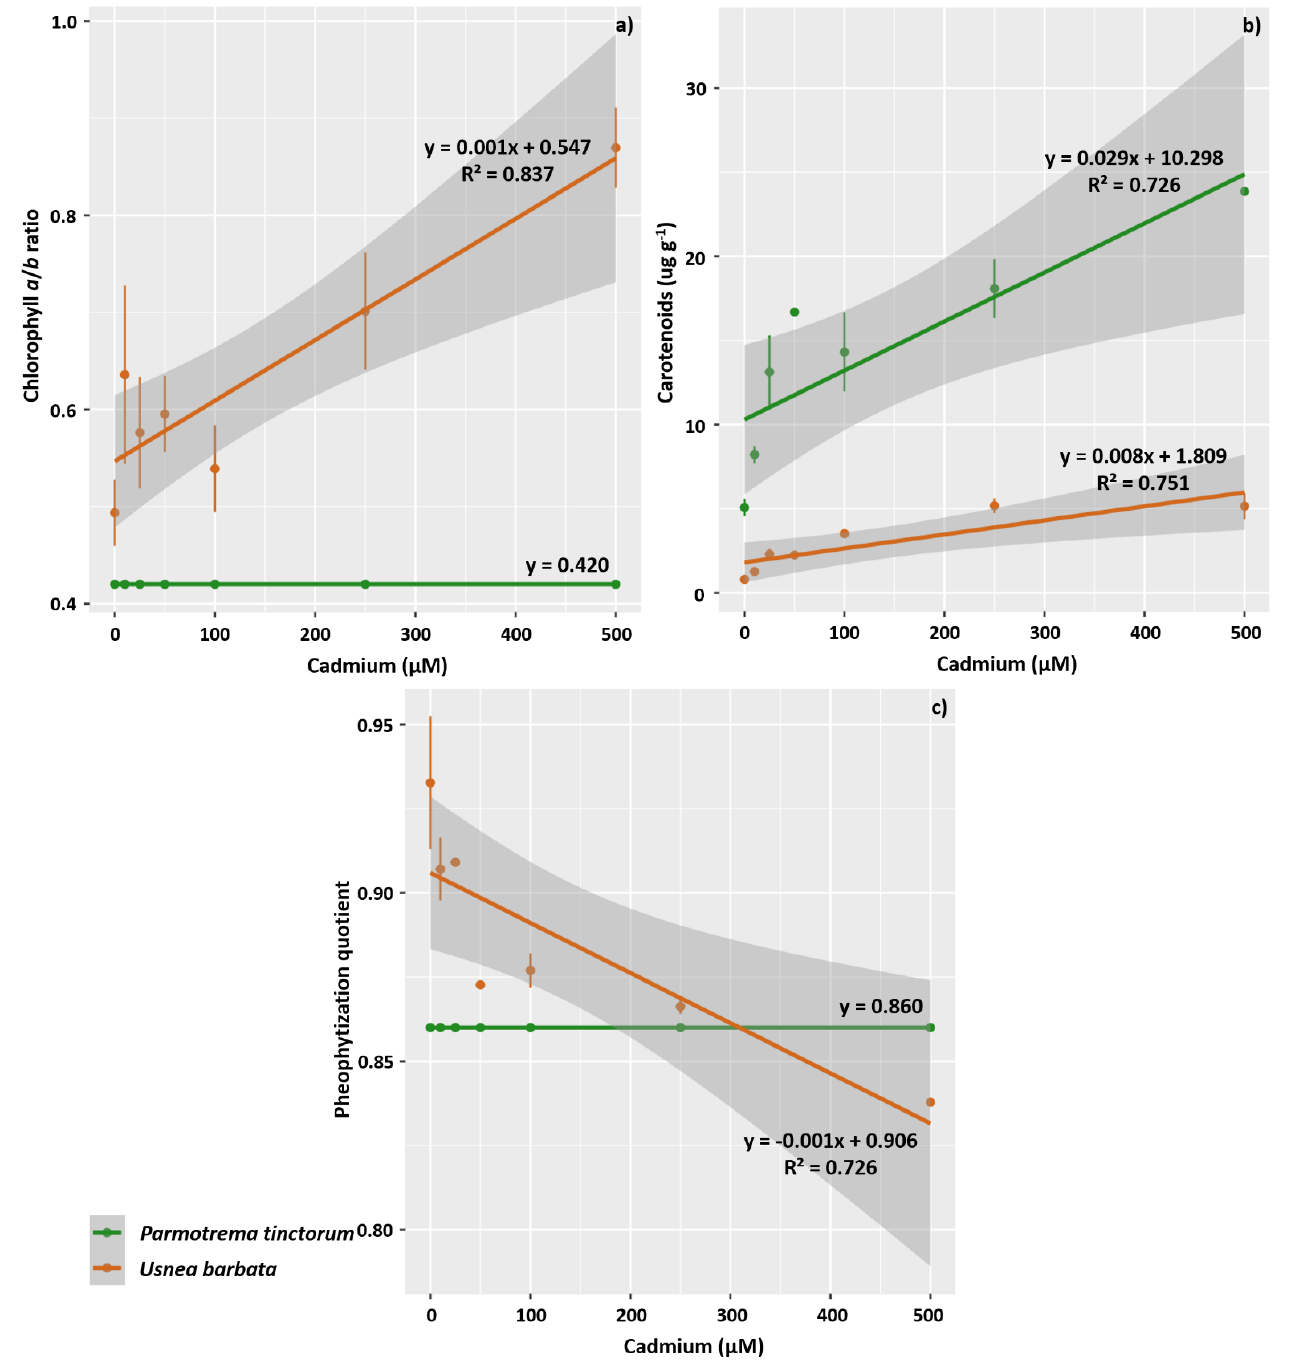
Figure 5. Chlorophyll a / b ratio ( a ), carotenoid concentration ( b ), and pheophytization quotient ( c ) observed for the photobionts of the lichen species Parmotrema tinctorum and Usnea barbata subjected to different concentrations of Cd (0, 10, 25, 50, 100, 250, and 500 µM). The straight lines represent the fitted model, and the prediction intervals (95%) are gray.